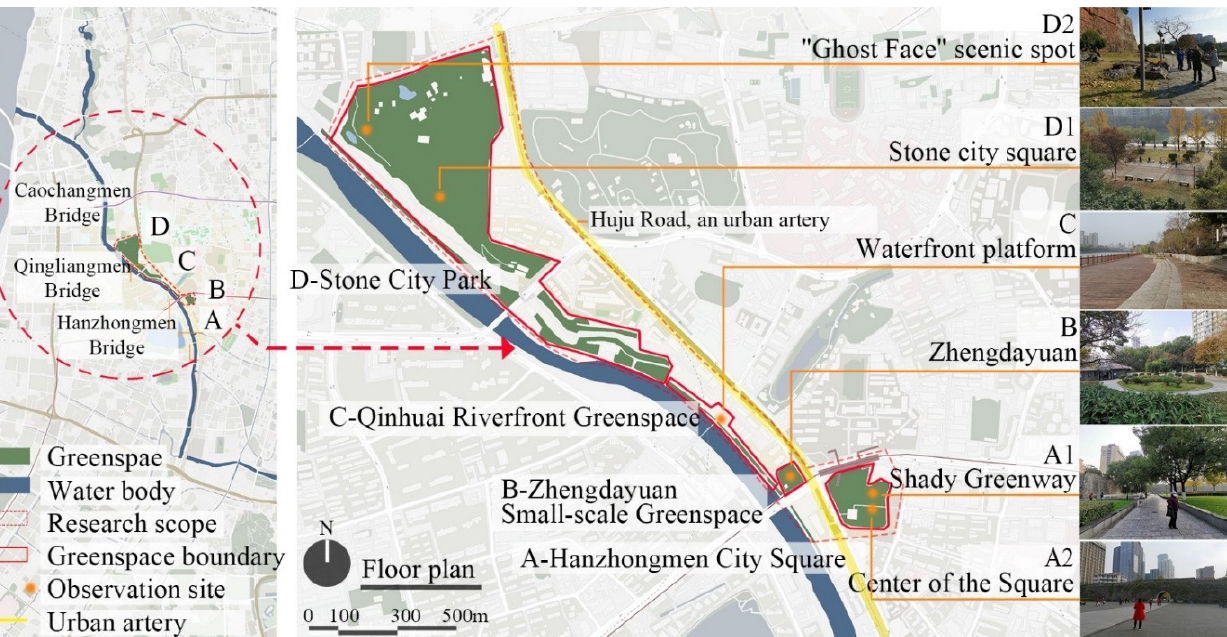
Figure 1. Locations of surveyed Nanjing greenspaces. Corresponding to the dual dimensions of physical and mental health, this study divides observed elderly activities within the sites into two types, physical activities (PA) and social activities (SA), although it is noted that the two categories can often overlap. Field observations of visitor activities (Table 1, Figure S2): in Sites A1 and A2, the elderly mainly engaged in social activities such as playing chess and cards, chatting and sitting